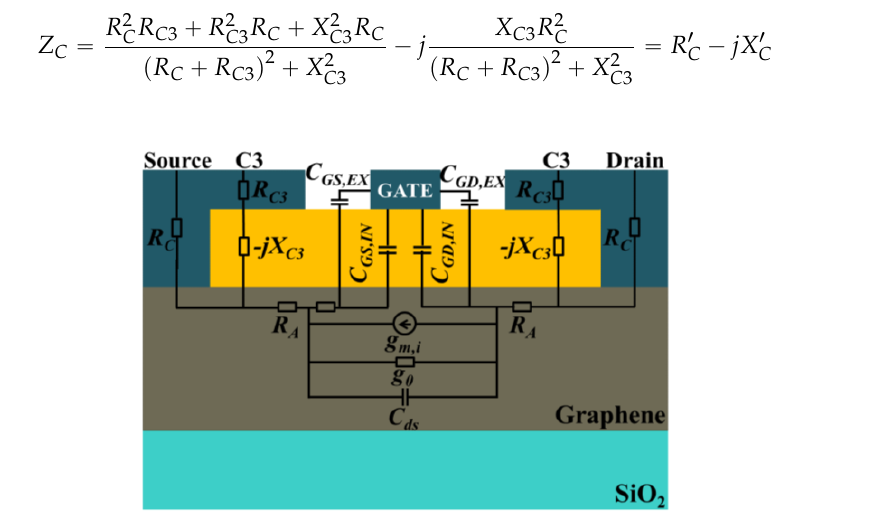
Figure 2. Small signal equivalent circuit overlaid on top of the proposed hybrid contact graphene FET.